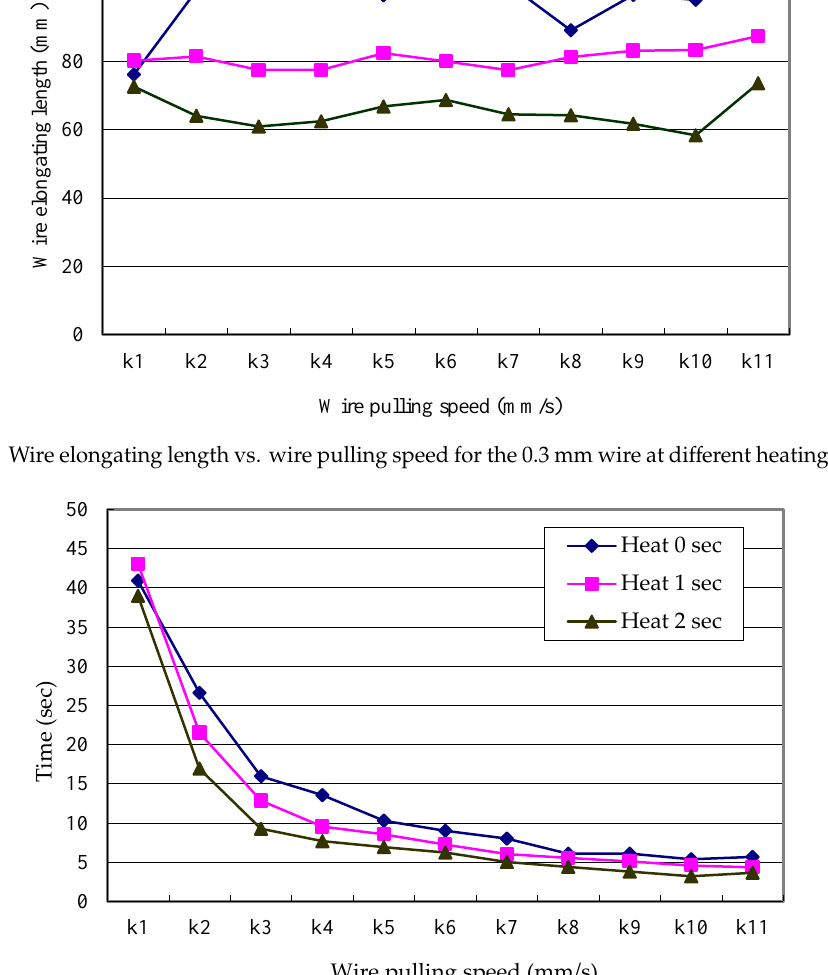
Figure 10. Wire elongating time vs. wire pulling speed for the 0.3 mm wire at different heating periods.